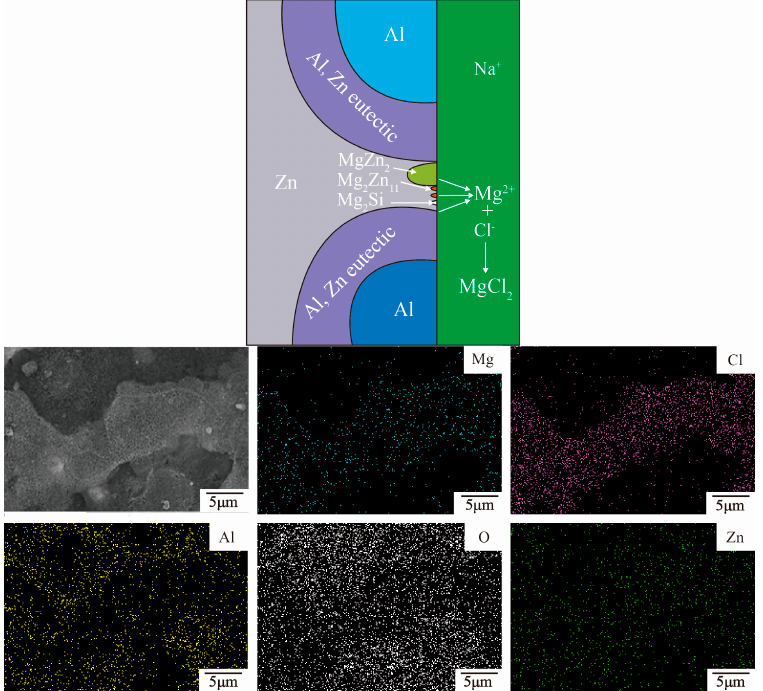
Figure 10. The schematic of the corrosion reaction and distribution of element on 23AZS–3Mg immersed for 47 days.